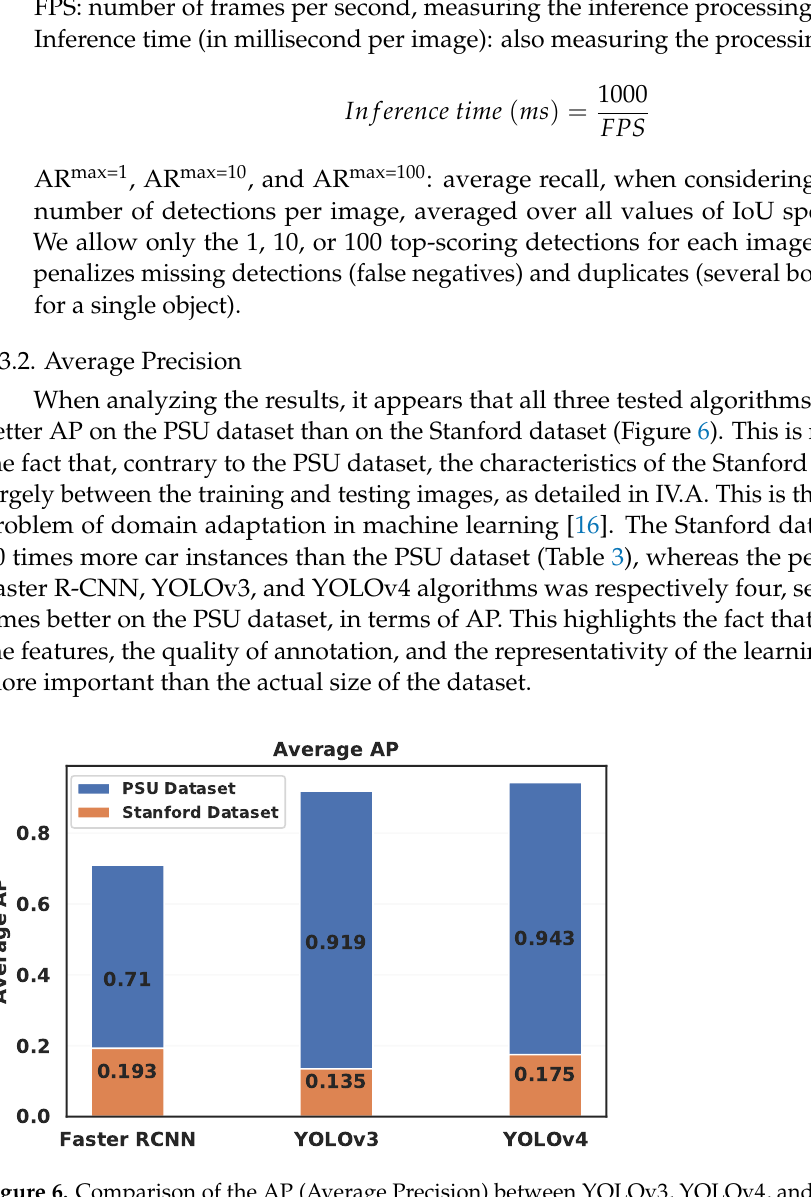
Figure 6. Comparison of the AP (Average Precision) between YOLOv3, YOLOv4, and Faster